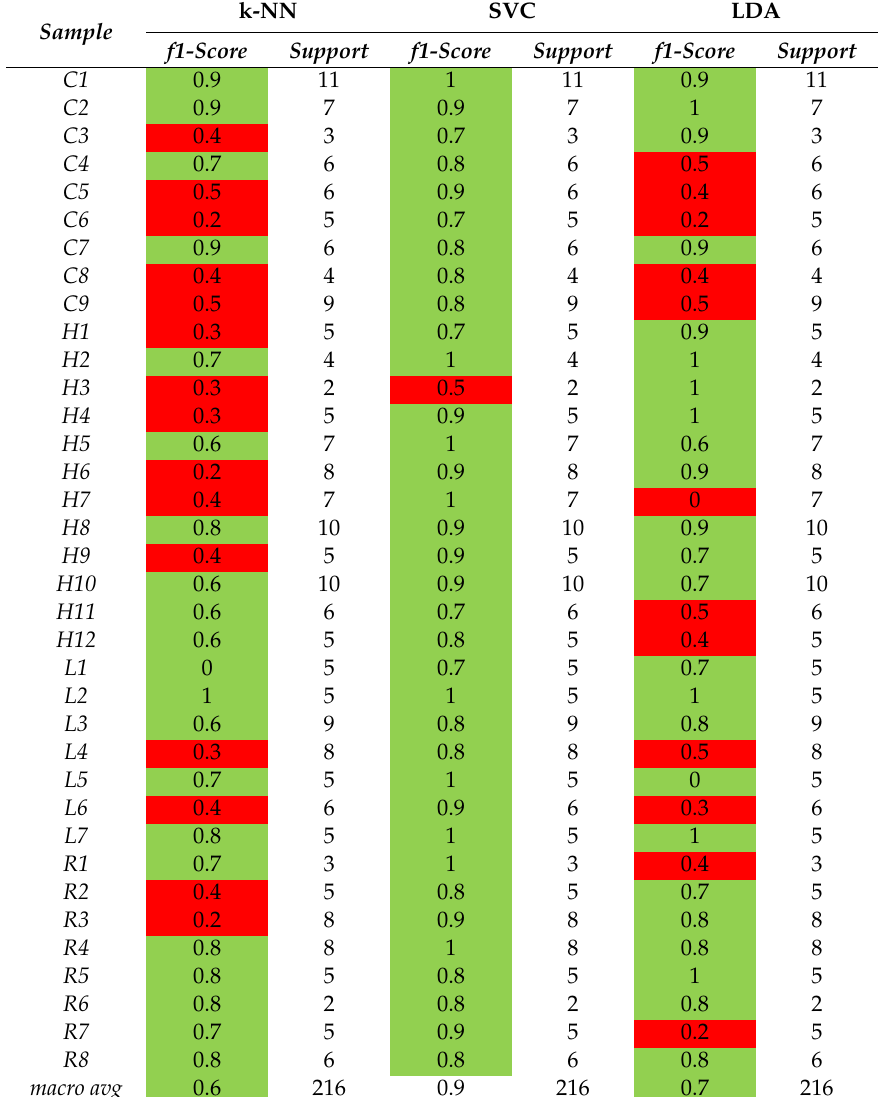
Table 1. Classification report for k-NN, SVC and LDA